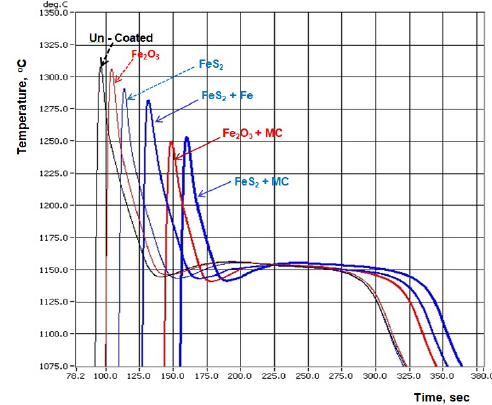
Figure 3. Solidification cooling curves of tested ductile cast irons, for uncoated and different inner- coated ceramic cups.